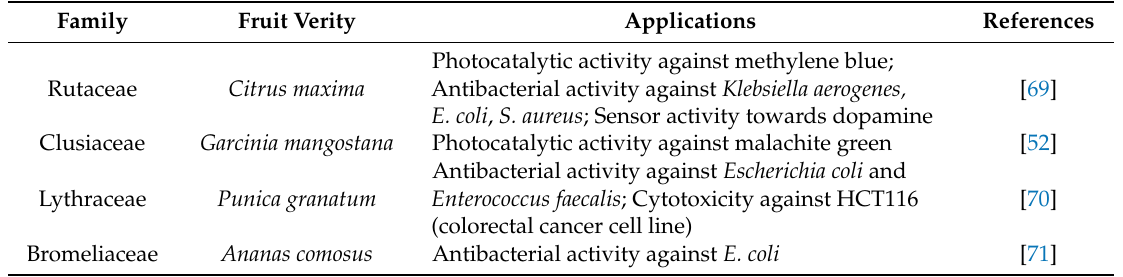
Table 6. Applications of zinc oxide NPs synthesized from various fruit